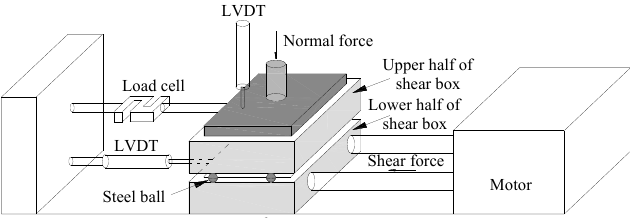
Figure 4. Schematic diagram of the direct shear device.